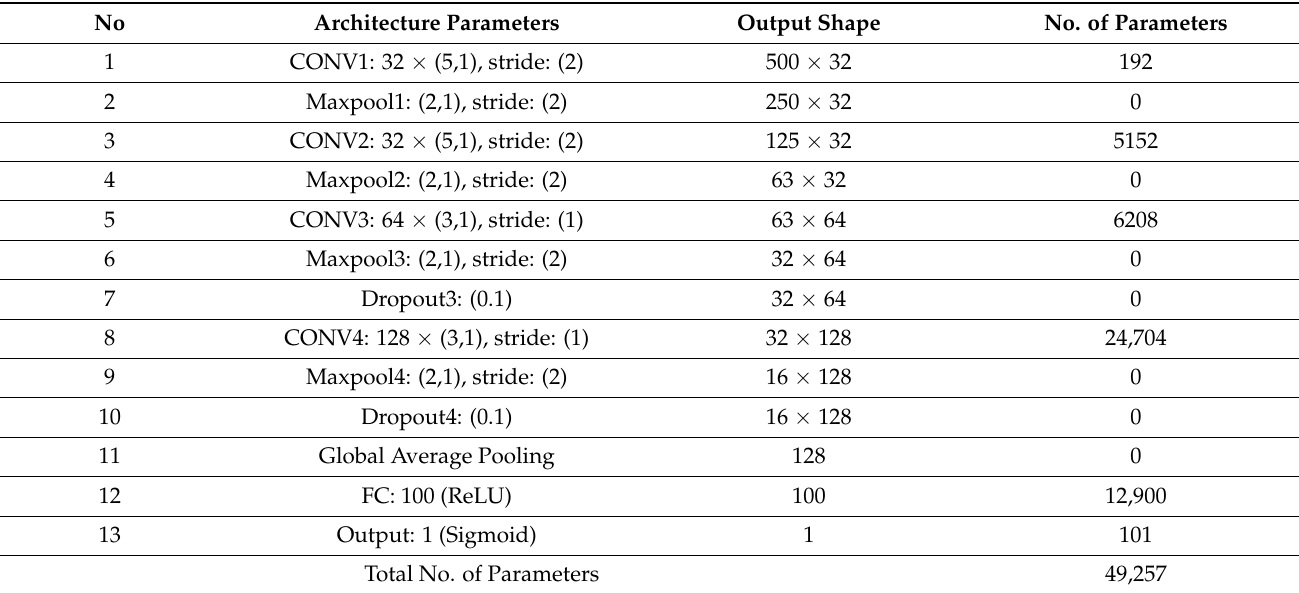
Table 2. Optimized CNN